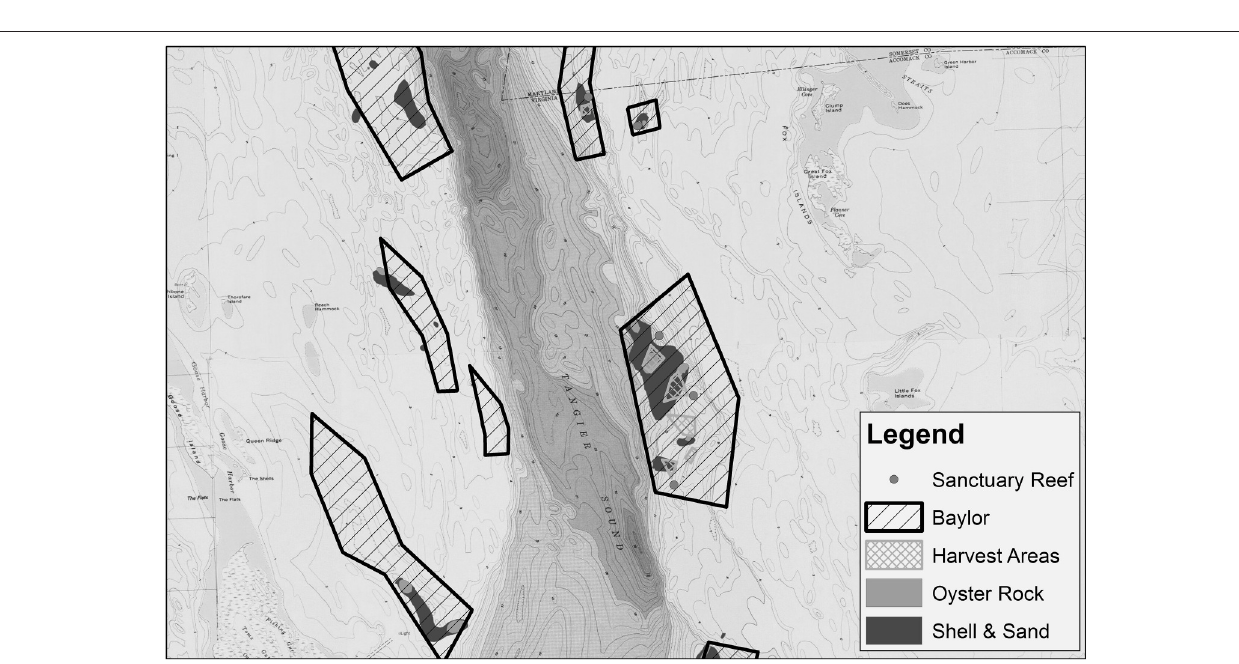
FIGURE 6 | Shell placement in TangierSound, 2002. Note a large portion of the shells were not placed on the highest quality “oyster rock” bottom areas.